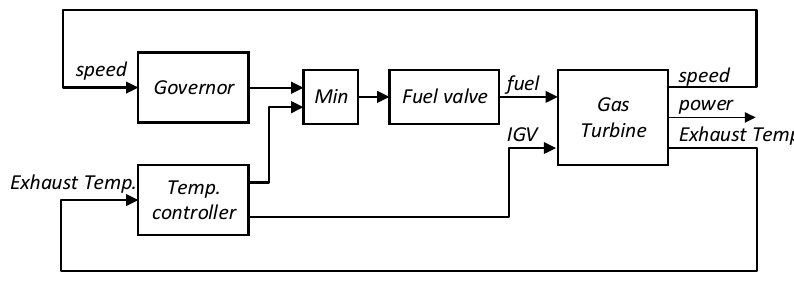
Figure 1. Gas turbine regular control configuration in island mode.